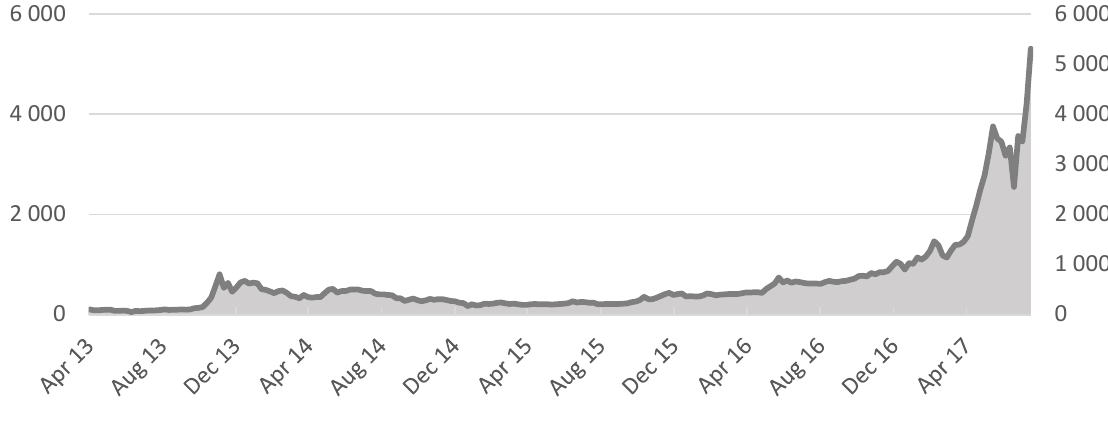
Figure 2. Cryptocurrency index from April 2013 to mid-August 2017, weekly